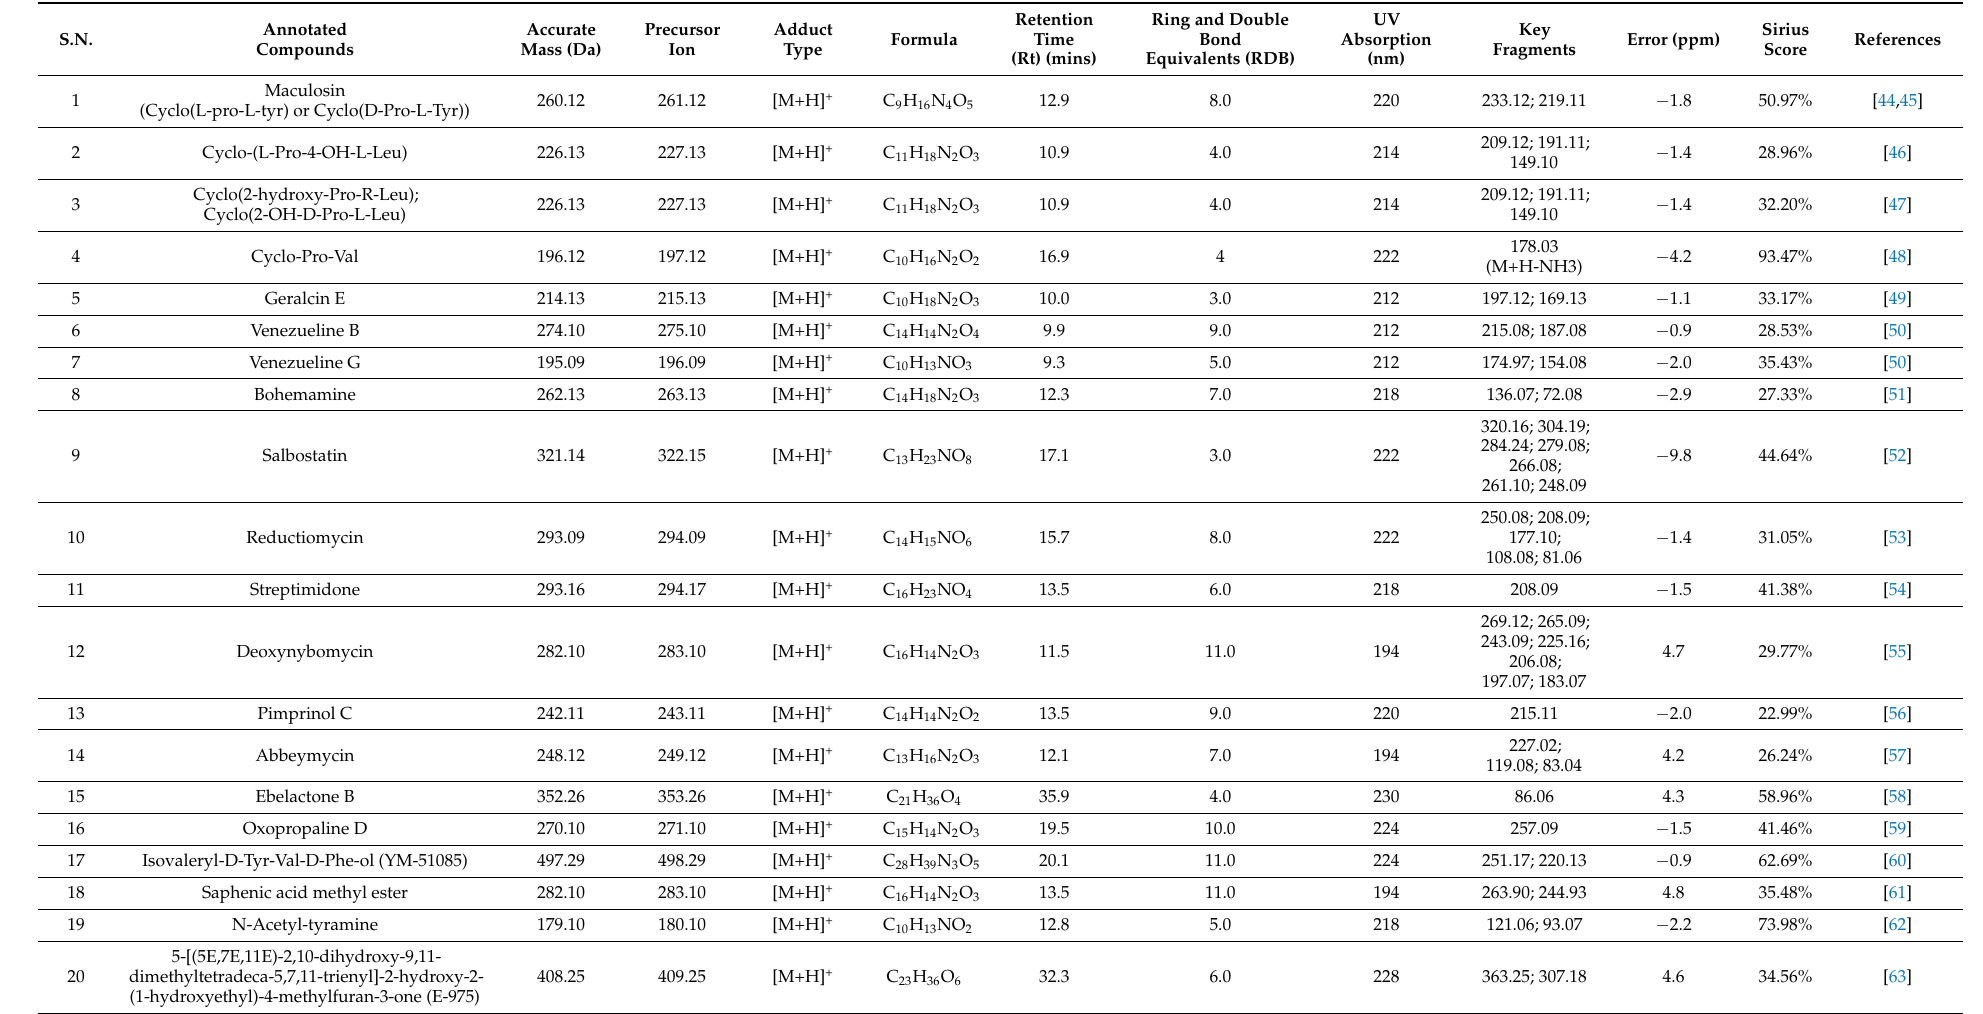
Table 1. A list of annotated compounds using SIRIUS in Streptomyces